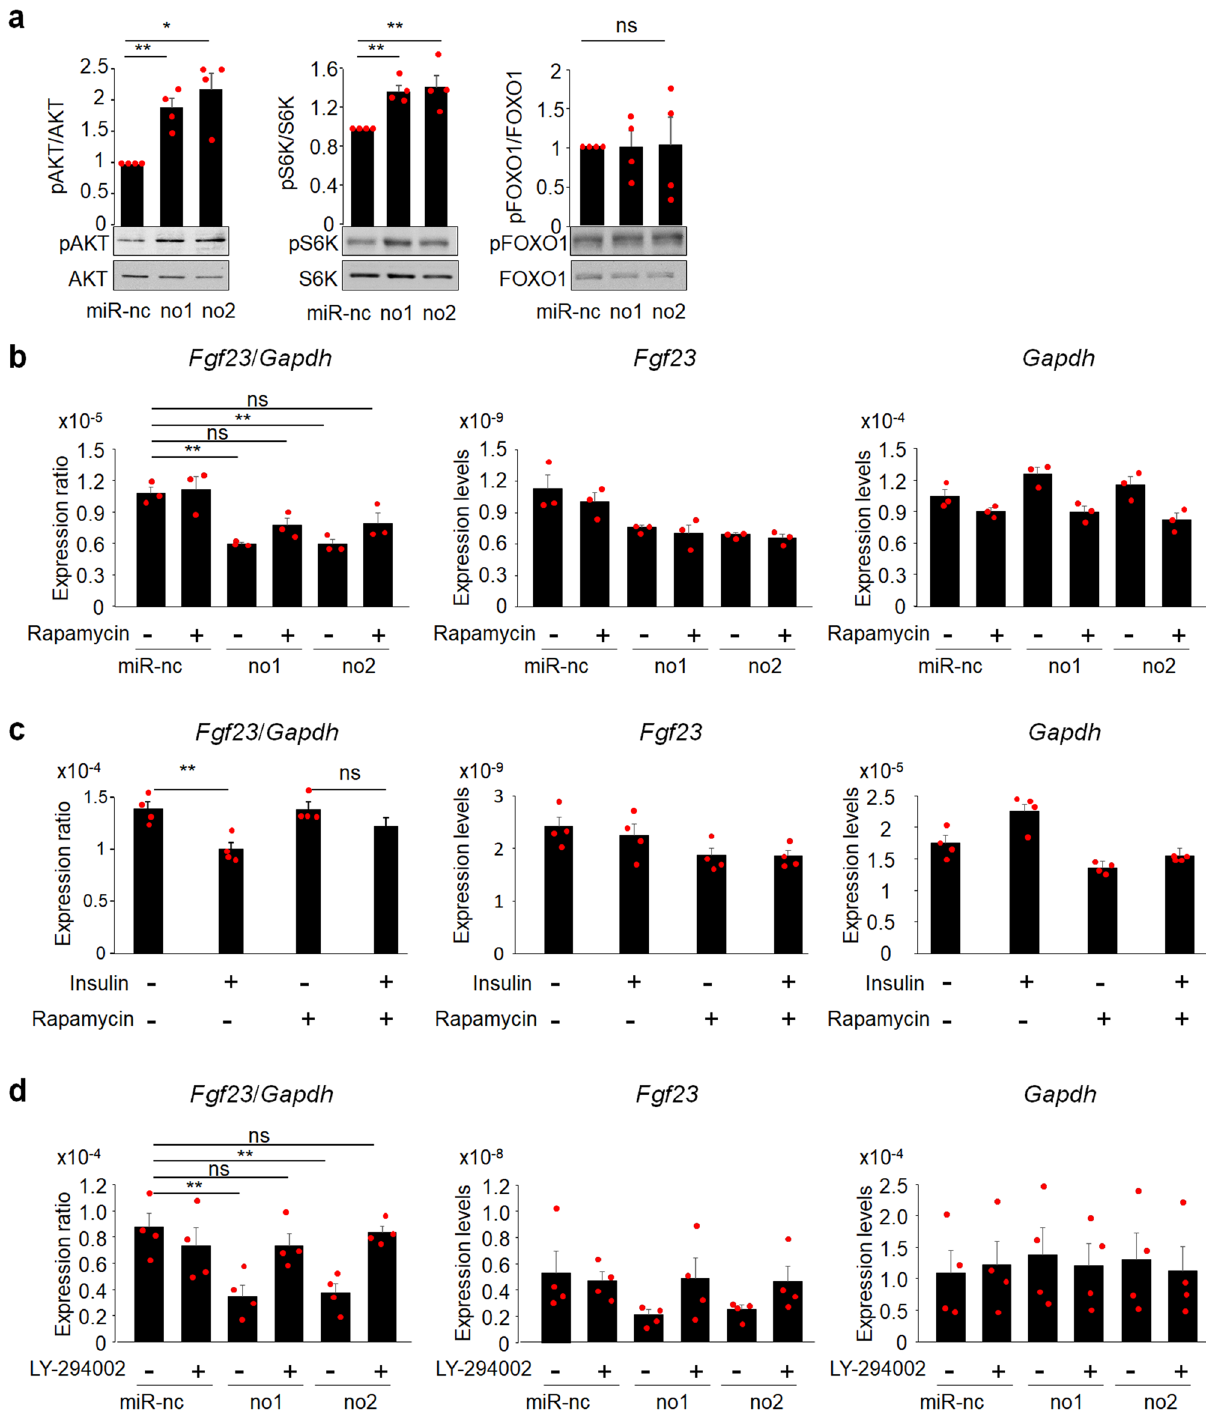
Figure 5. Suppression of Fgf23 expression by PTEN knockdown or insulin was partially restored in the presence of rapamycin in UMR106 cells. ( a ) The expression of PTEN was knocked down using a lentiviral system in UMR106 cells and the expression of pAKT/AKT, pS6K/S6K, and pFOXO1/FOXO1 was assessed by a Western blot analysis, which was followed by a densitometric analysis (N = 4). ( b ) The expression of PTEN was knocked down using a lentiviral system in UMR106 cells and treated with 10 nM of rapamycin ( b ). The expression of Fgf23 and Gapdh was assessed by a real-time RT-PCR analysis and the expression ratio of Fgf23 / Gapdh was determined. Statistical analysis was performed after corrected for the expression of Gapdh (N = 3). ( c ) UMR106 cells were pre-treated with 10 nM of rapamycin for 6 h, followed by an overnight treatment with 50 nM of insulin. The expression ratio of Fgf23 / Gapdh was determined. Statistical analysis was performed after corrected for the expression of Gapdh (N = 4). ( d ) The expression of PTEN was knocked down using a lentiviral system in UMR106 cells and treated with 5 μM of LY-294002. The expression of Fgf23 and Gapdh was assessed by a real-time RT-PCR analysis and the expression ratio of Fgf23 / Gapdh was determined. Statistical analysis was performed after corrected for the expression of Gapdh (N = 4). Statistical analysis was performed using one-way ANOVA. * p < 0.01; ** p < 0.05, ns: not significantly